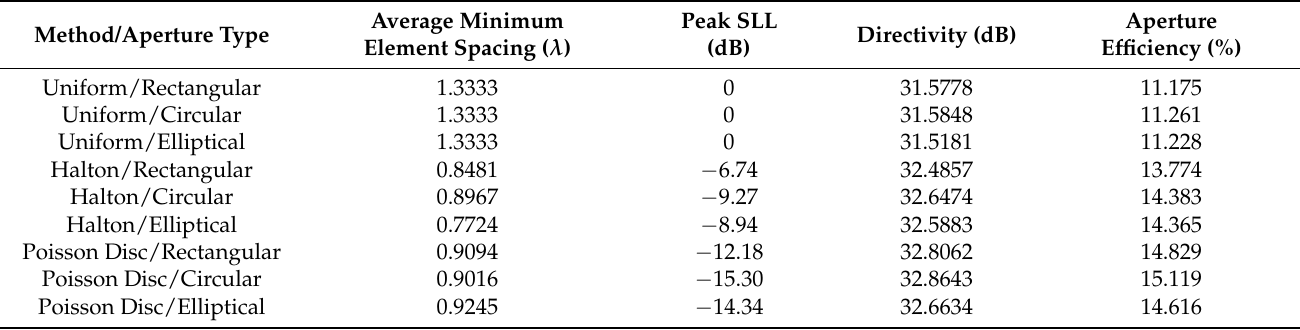
Table 2. Performance metrics for sparse antenna arrays with rectangular, circular, and elliptical apertures and different element